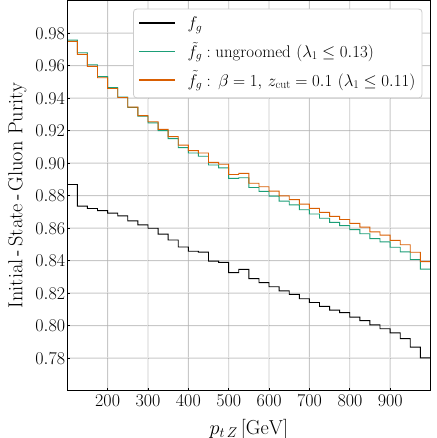
curve with the target line set our tagger working points.